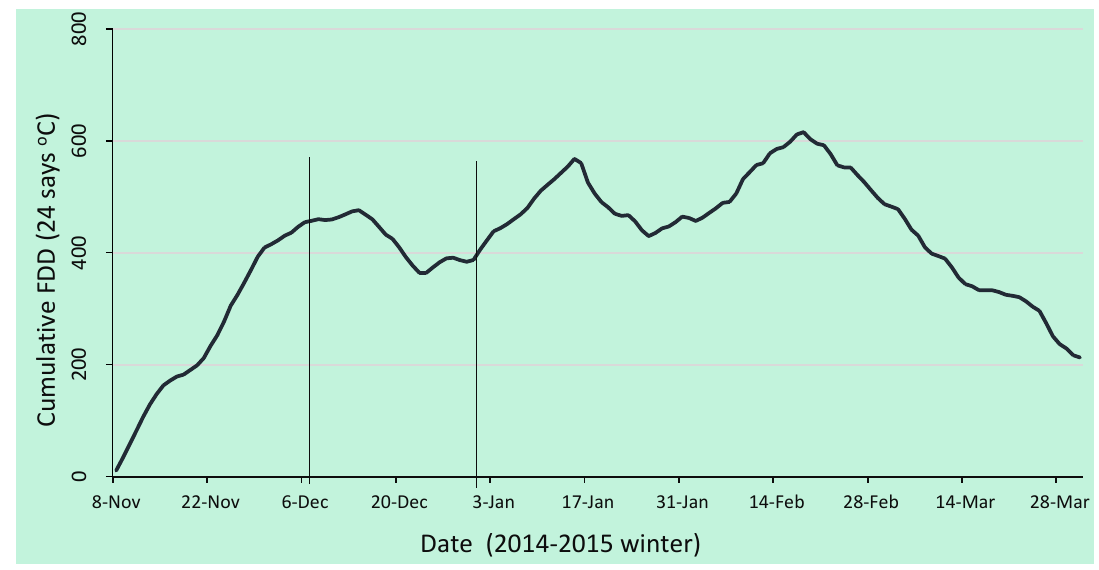
Figure 19. Cumulative freezing degree days (FDD) recorded at Fort Smith during the freeze-up period in winter 2015. The two vertical lines indicate the dates ( i.e. , 10 December and 3 January) of the acquired RADARSAT images in the 2014–2015 winter as shown in Figure 12 (data source: Environment Canada